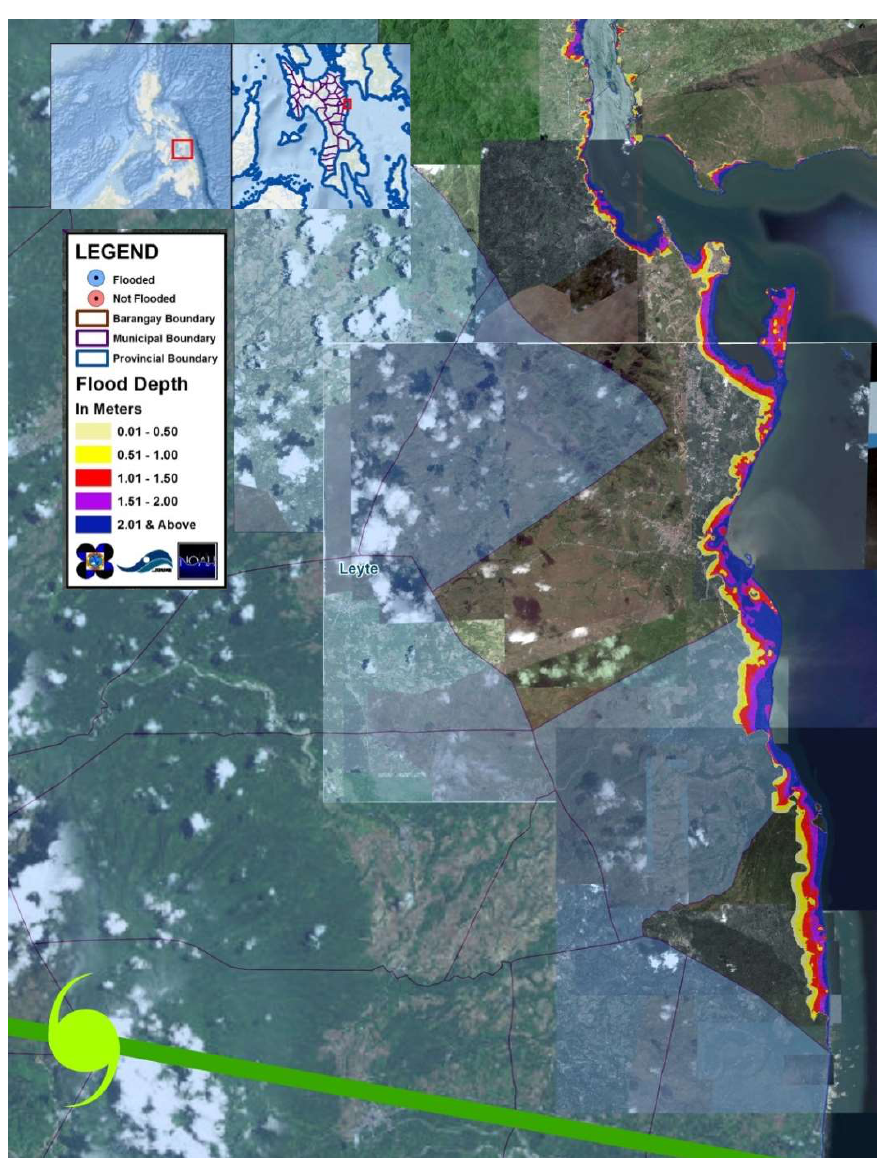
Figure 15. Effect of typhoon’s approach angle on storm surge flow depth. The area delineated by the red box shows coasts directly perpendicular to the typhoon’s wind direction, whereas the blue boxed area shows the coast that is parallel to the wind direction.